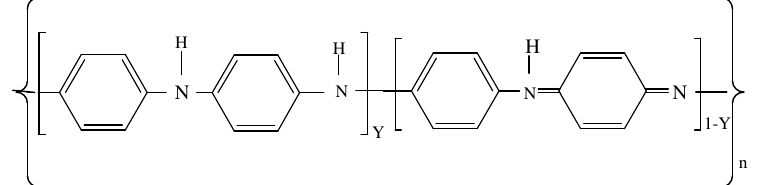
Figure 1 The general structure of PAni conducting